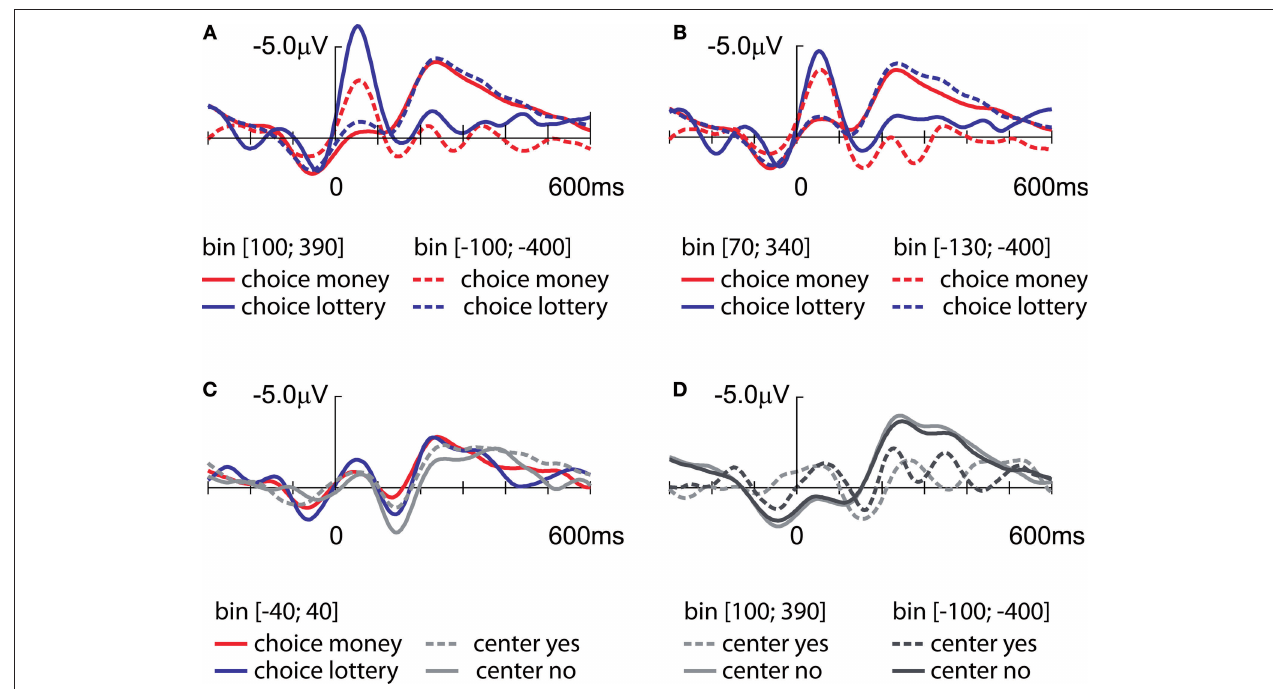
FIGURE 5 | Response-locked event related potentials for the lottery’s task endpoints (A), the bisection’s task endpoint (C) and the indifference point for all conditions (D) at Cz are shown. (B) Depicts the lottery’s task ERPs which are corresponding to the bins equidistant to the indifference point [bin 70;340] and choice money [ − 130; −